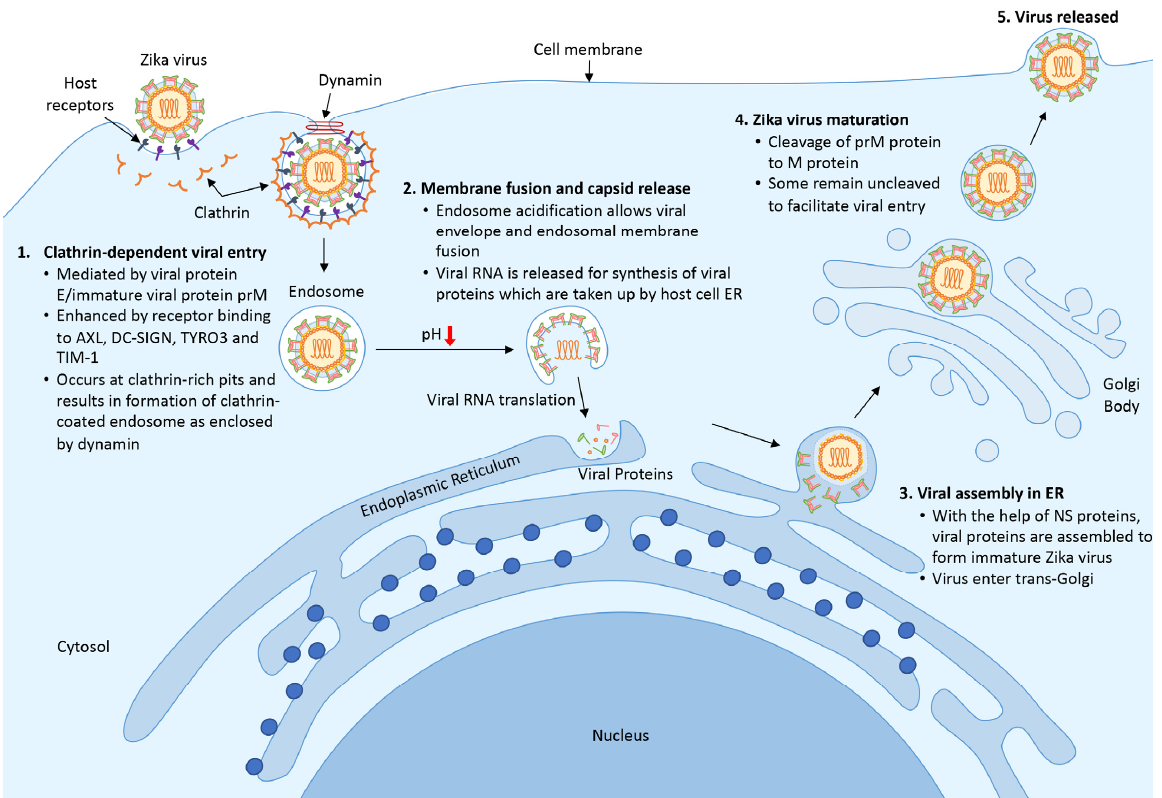
Figure 1. Life cycle of ZIKV. (1) ZIKV encounters host cells and binds to host receptors (AXL, DC- SIGN, TYRO3, and TIM-1) via viral protein E and prM and initiates clathrin-dependent viral entry. (2) Upon entering the cell, the endosome matures and acidifies, resulting in the release of viral RNA and the translational process to synthesize viral proteins. (3) New viral proteins are assembled into an immature viral particle within the endoplasmic reticulum. (4) Immature viral particles enter the trans-Golgi network where prM protein is cleaved into a mature virus. Finally, the newly formed virus is released to the surrounding areas and is ready for subsequent infection.